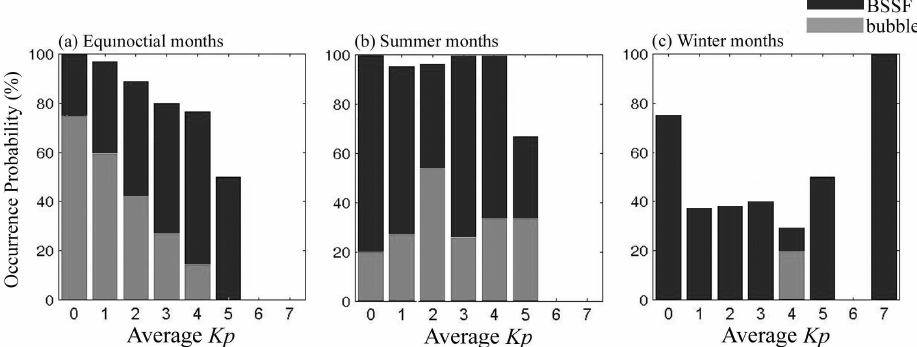
Fig. 6. Occurrence probabilities of BSSF (black bar) and bubble (gray bar) for equinoctial (a) , summer (b) , and winter (c) months plotted as a function of K p determined as the average during the 6h prior to measurement.